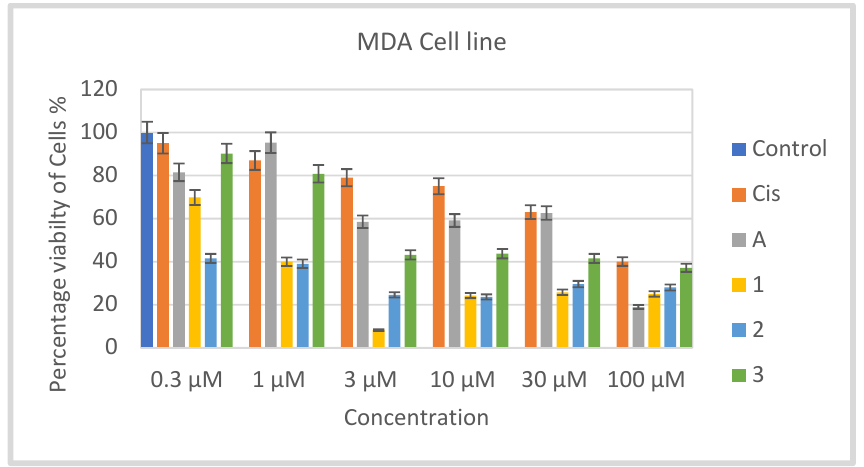
Figure 4. Effect of the concentration of complexes A, 1 – 3 and cisplatin on the viability of MDA cells.